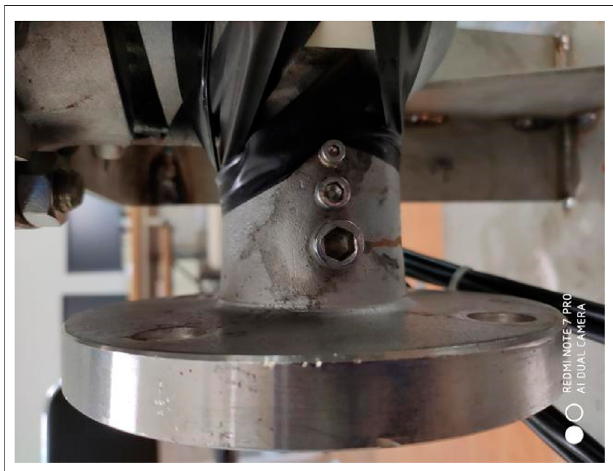
FIGURE 3 | The electric valve studied in the experiment to simulate degradation.